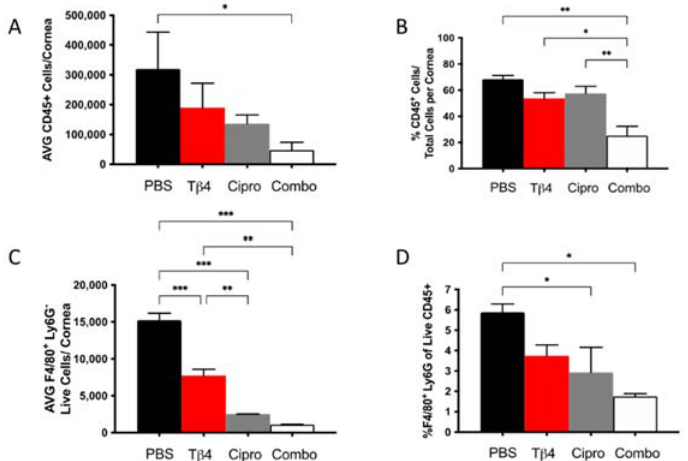
Figure 2. Flow cytometry results of inflammatory cellular infiltrates following infection. CD45 + leukocytes ( A , B ) and CD45 + F4/80 + Ly6G − M Φ ( C , D ) as determined by flow cytometry at 3 days p.i. in corneas of PBS ‐ , T β 4 ‐ , cipro ‐ , and combo ‐ treated B6 mice. Results are shown as averages of single cell populations ( A , C ), % of leukocytes per total cells per cornea ( B ), or % of live M Φ per total pop ‐ ulation of live leukocytes ( D ). n = 5 corneas/group; * p < 0.05, ** p < 0.01, *** p < 0.001.